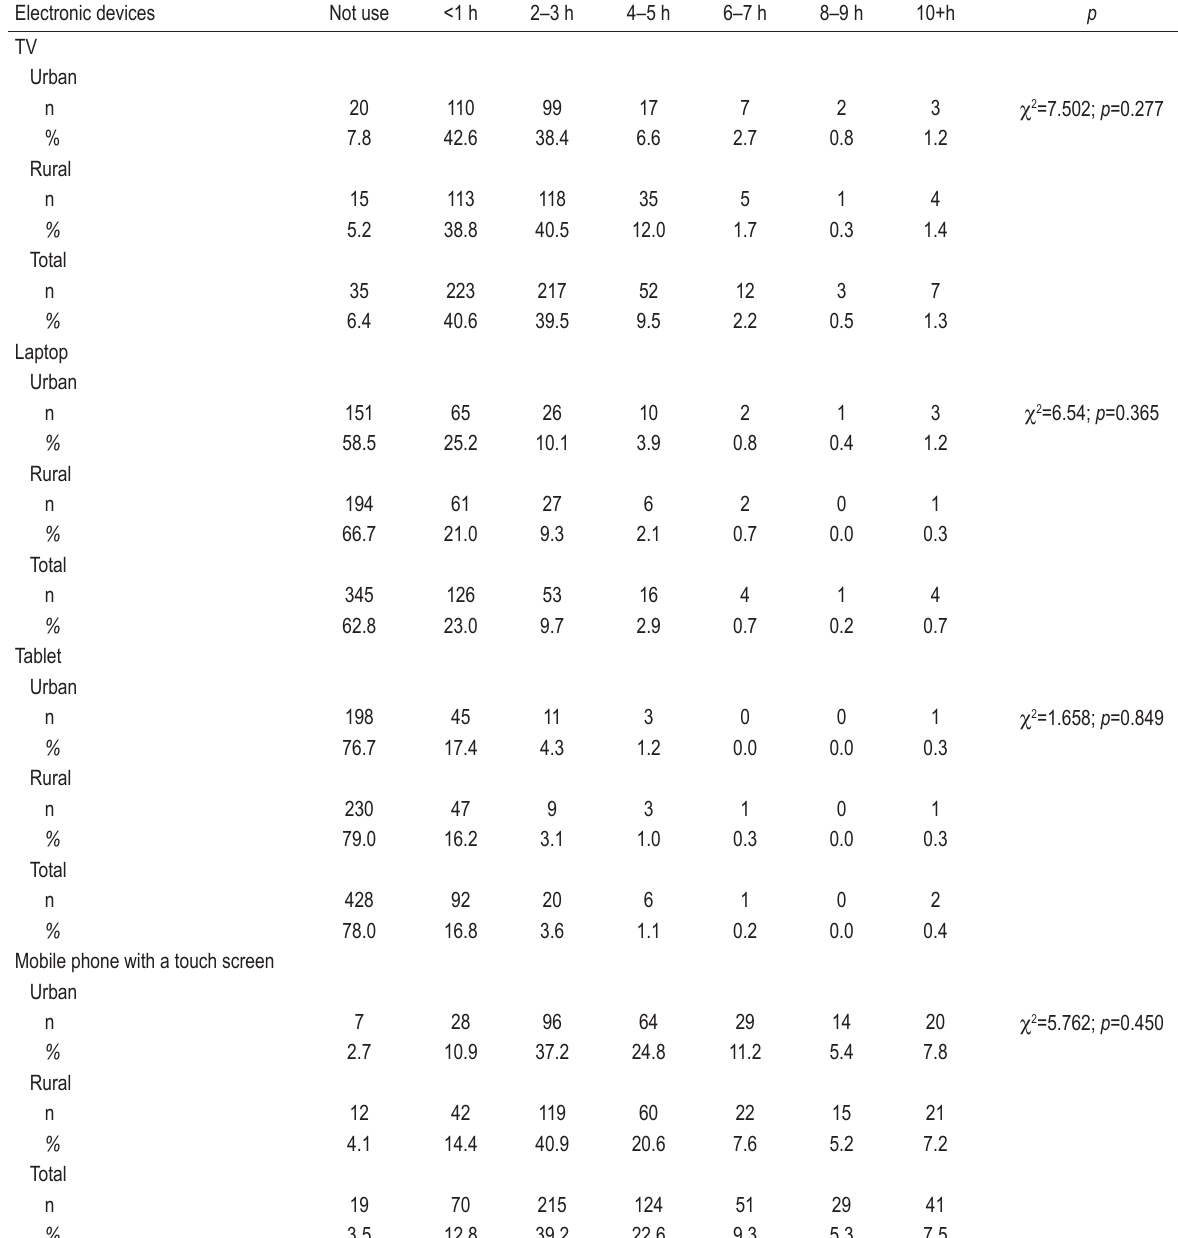
TABLE 1. The review of the duration of use of electronic devices within a working week (Monday–Friday) according to areas Electronic